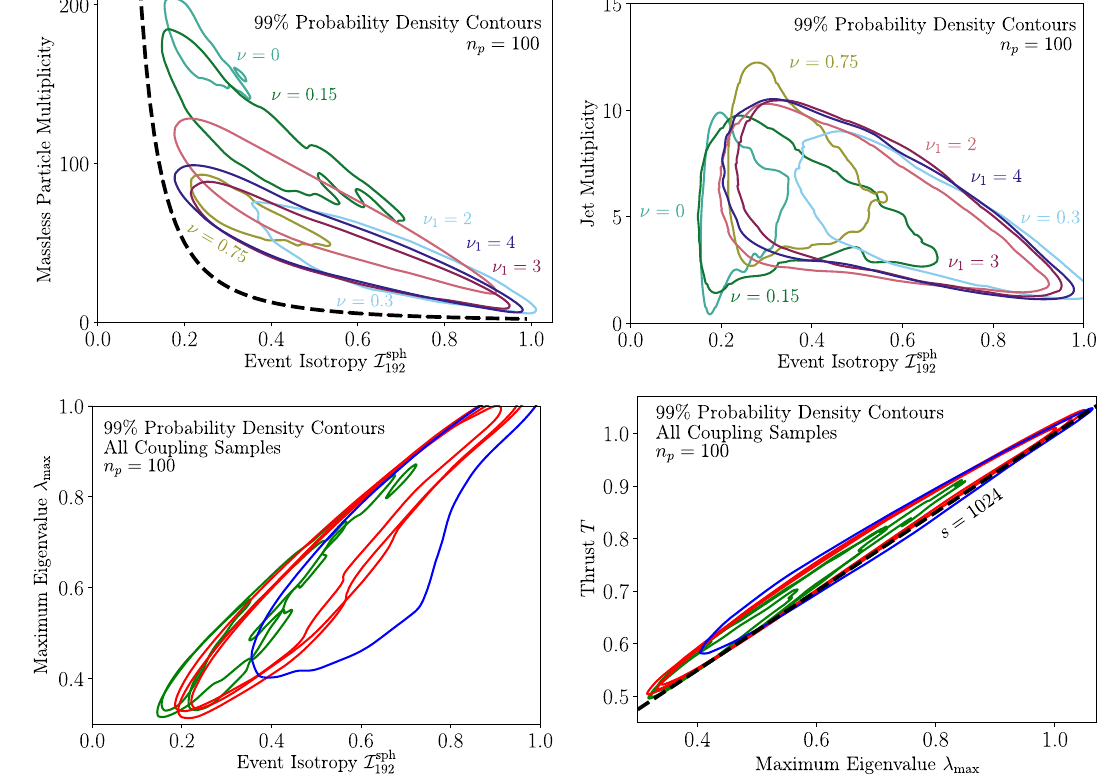
Fig. 17 Correlations between event isotropy and other canonical event shape observables calculated on quasi-isotropic events generated using the framework of Ref. [111], such as particle multiplicity (left top), jet multiplicity (right top), and the maximum eigenvalue of the sphericity tensor (left bottom), which is closely related to the C and D parameter